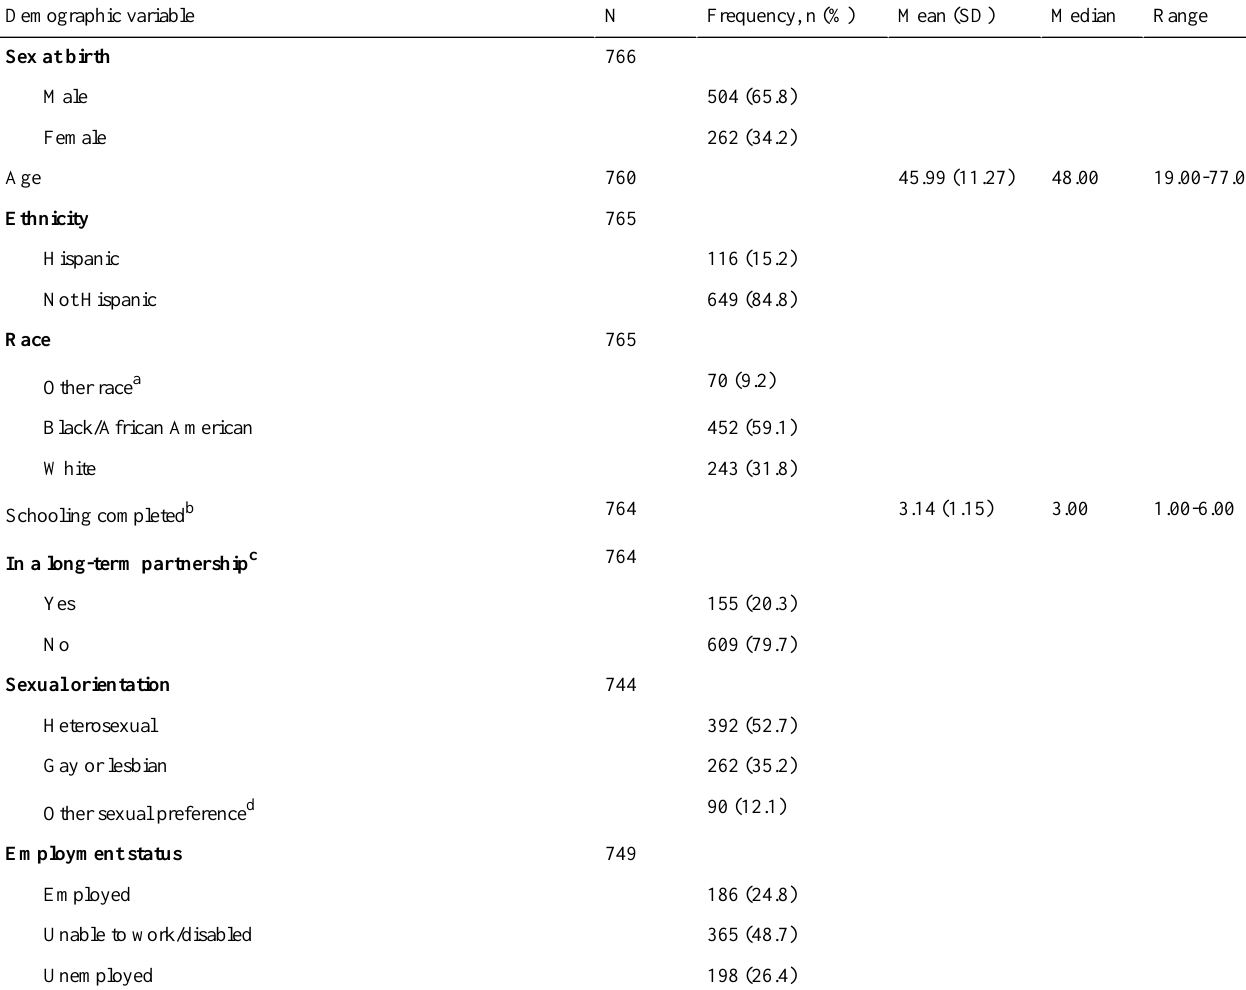
Table 1. Demographic characteristics